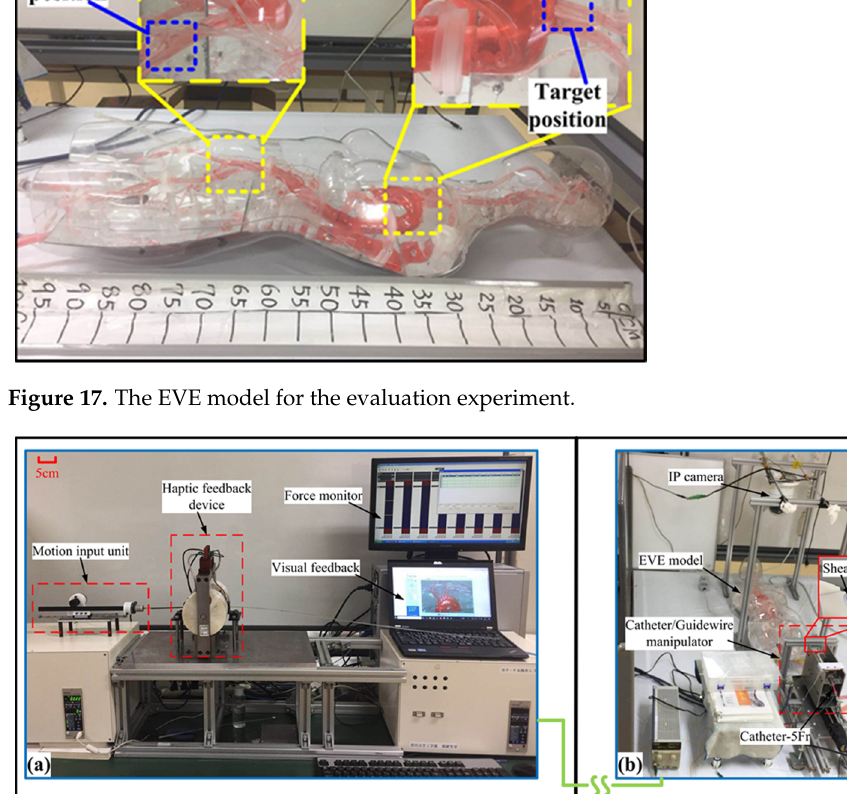
Figure 17. The EVE model for the evaluation experiment.